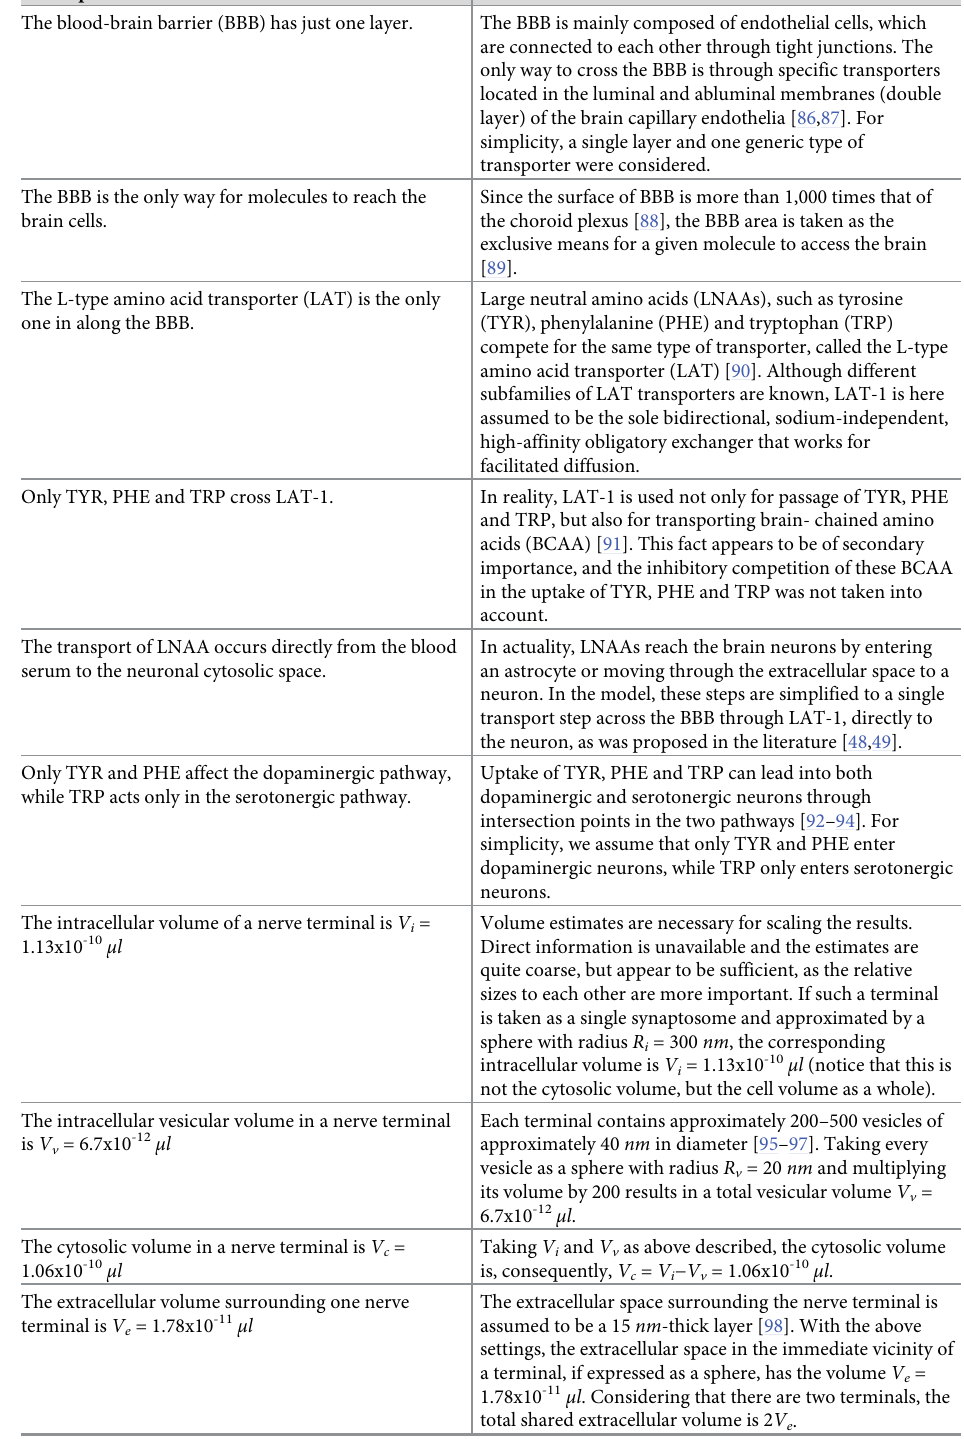
Table 2. Summary of general assumptions made during model